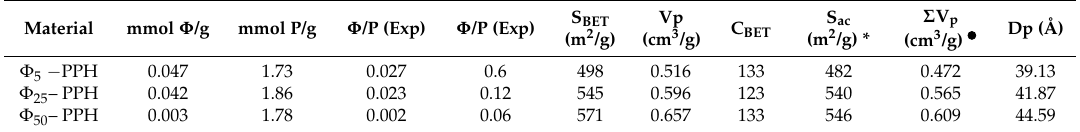
Figure 1. UV-Vis spectra of Φ 5 -PPH, Φ 25 -PPH and Φ 50 -PPH at 210 nm in hexane. Table 2. Characteristics of the different materials